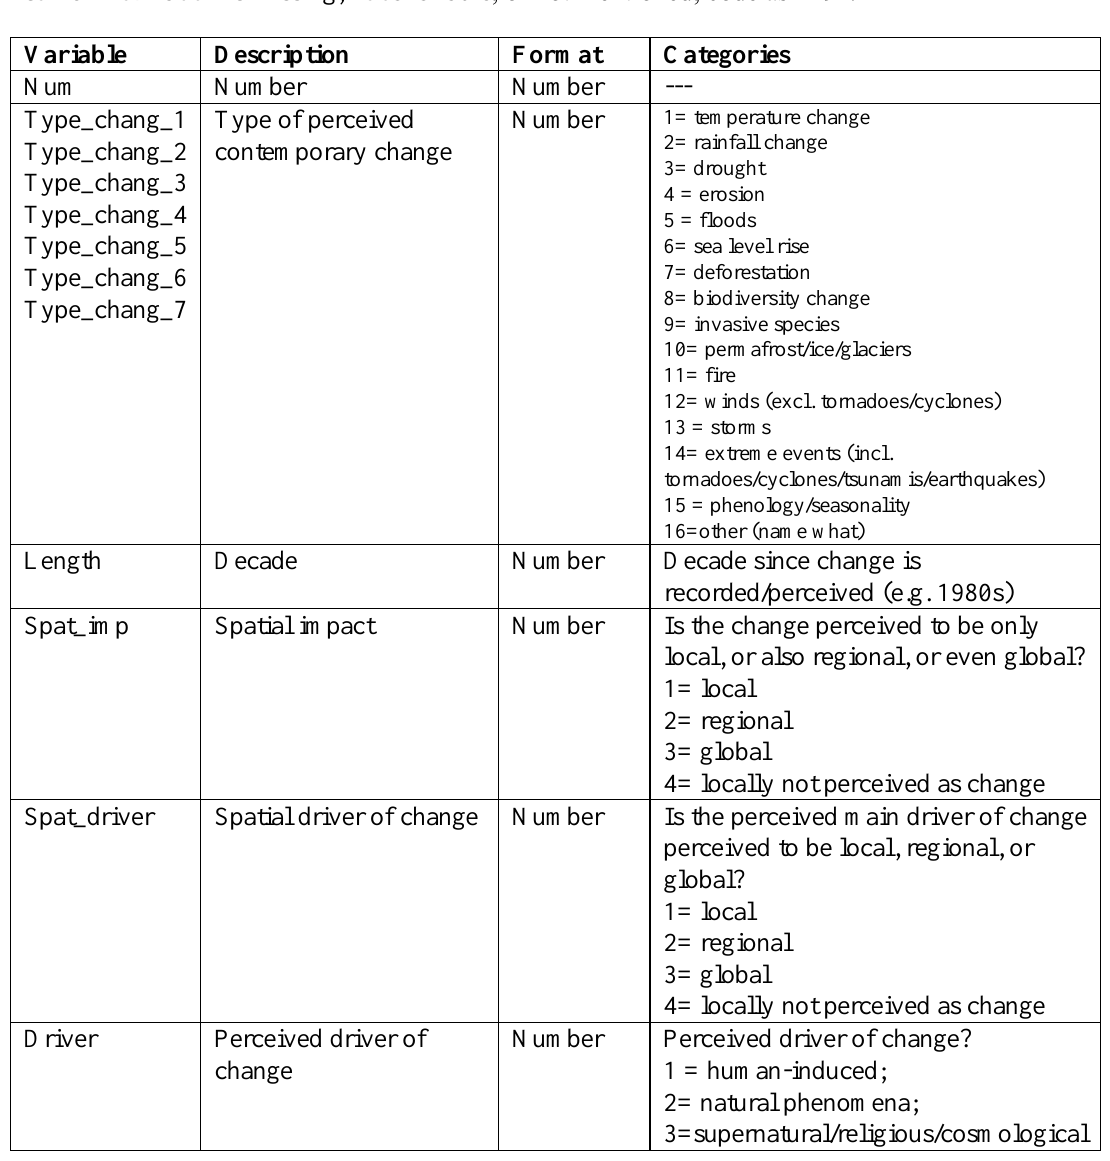
Table A2. Perceptions and understandings of Global Environmental Change This Table is intended to compile all the information on the perceptions, understandings and manifestations of Global Environmental Change in the publications referred to in Table 2. If some information is missing, not available, or not mentioned, code as “